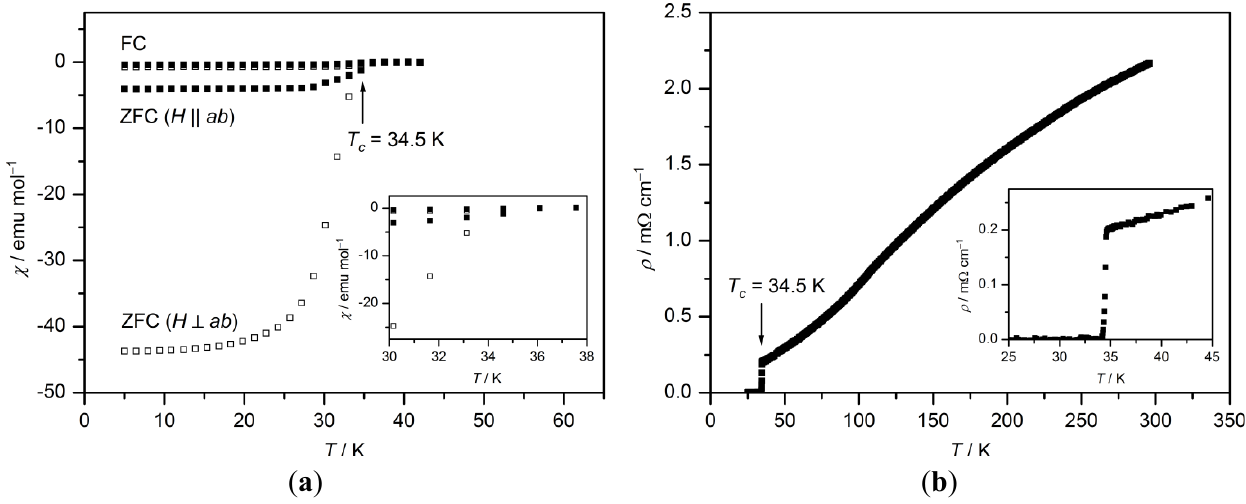
Na FFeAs single crystals. ( H 0.89 0.11